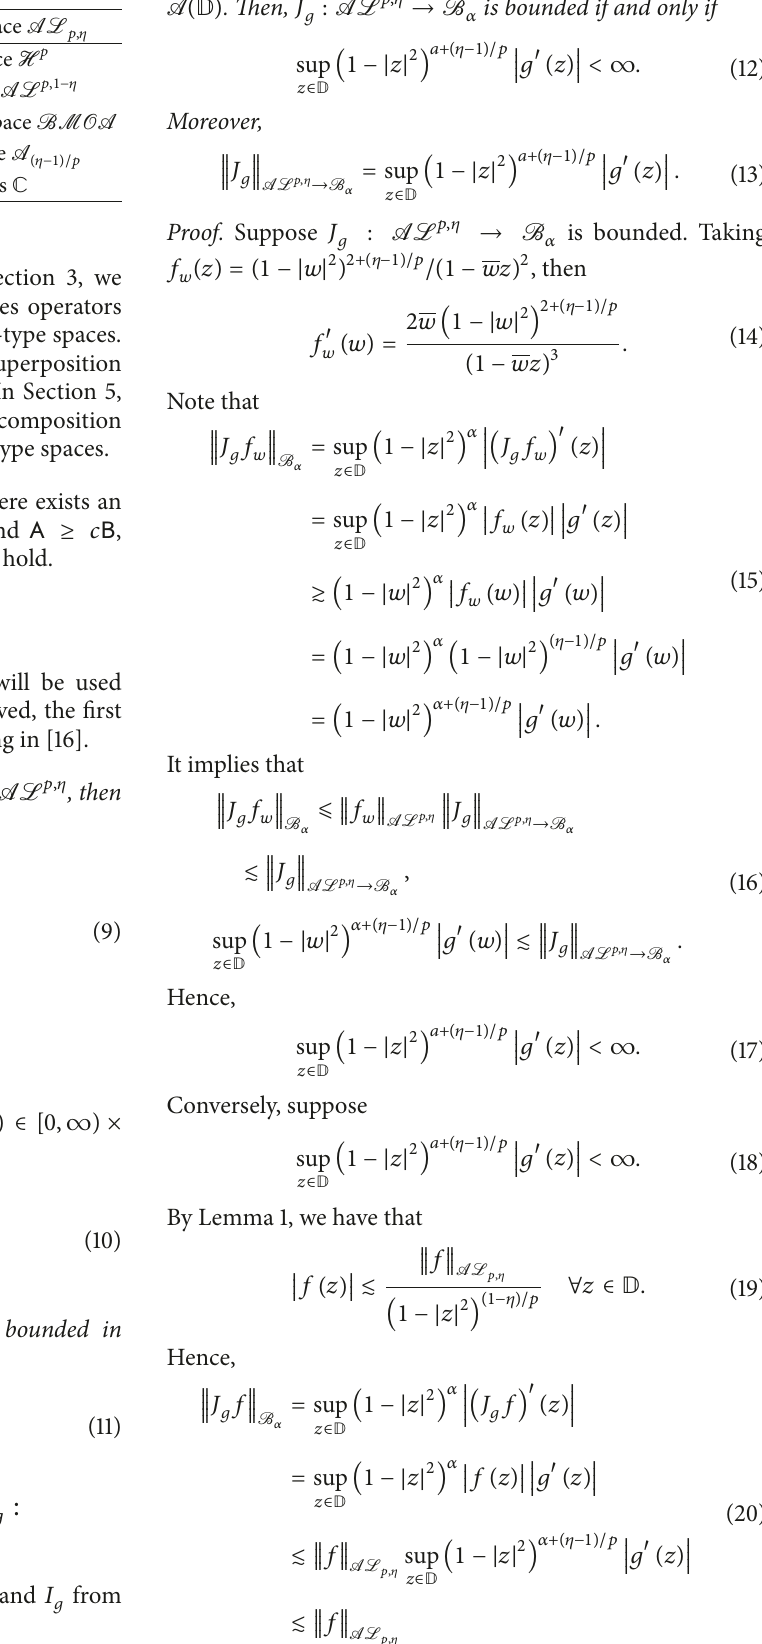
Table 1: The structure of analytic Campanato